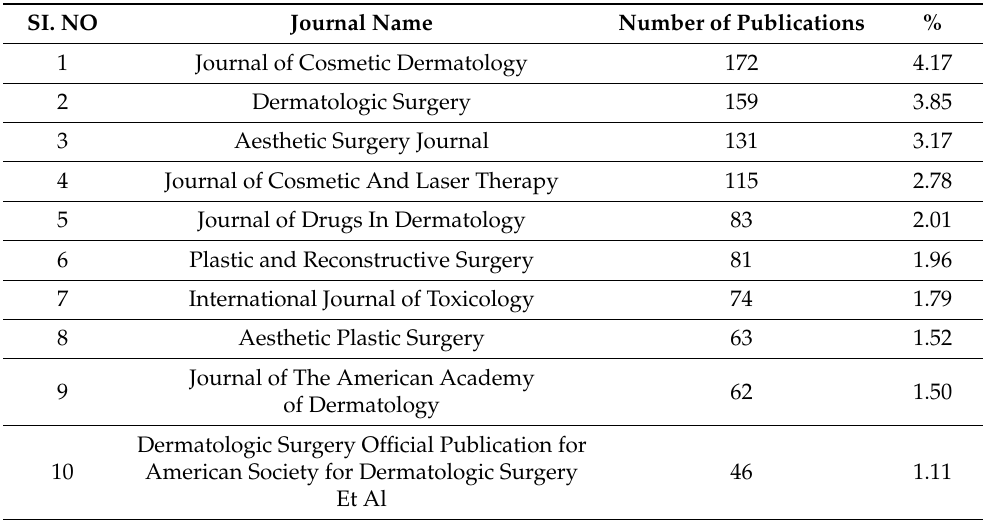
Table 5. The top ten journals by the number of published documents. SI.